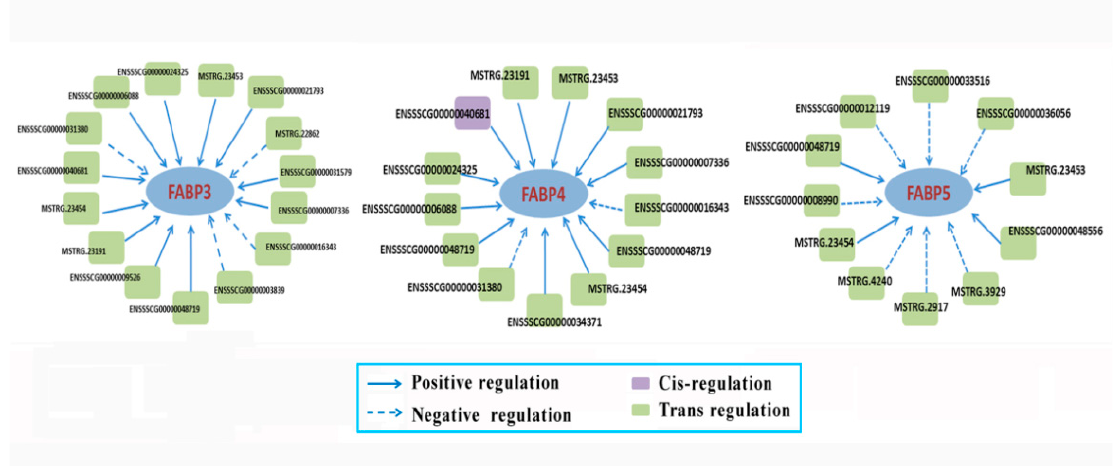
Figure 10. The lncRNAs targeted FABP genes by cis- or tans-regulation.